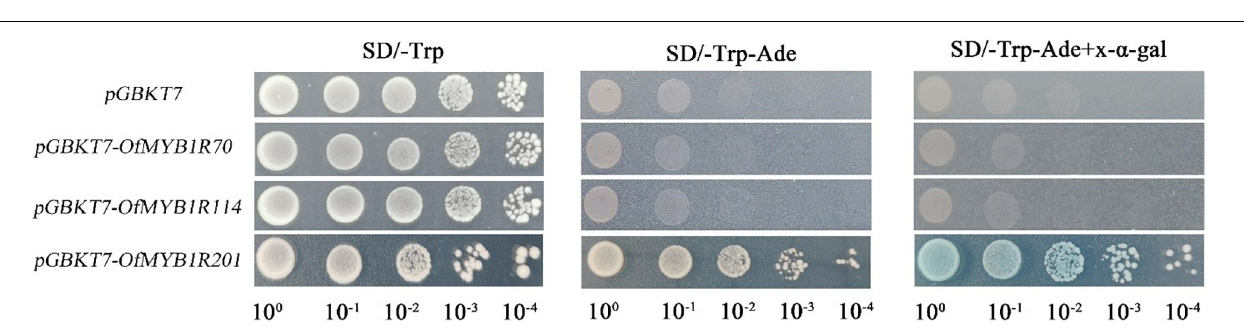
nonanal, and benzeneacetaldehyde ( Supplementary Table 6